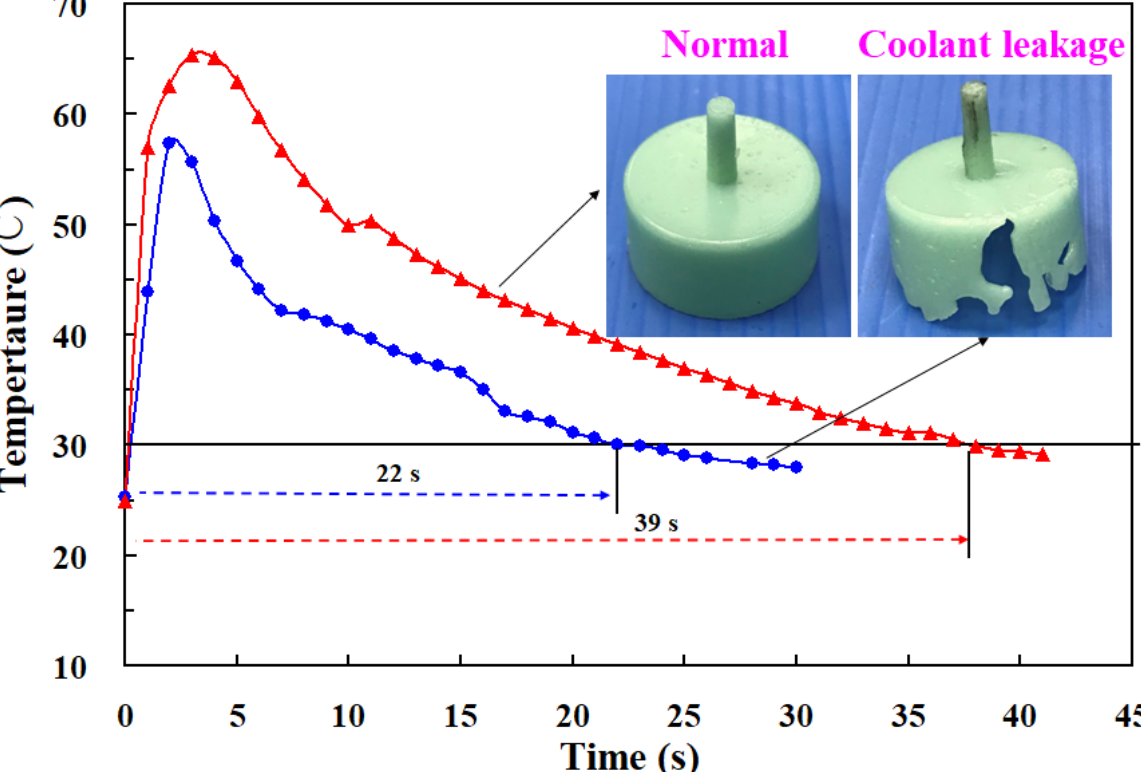
Figure 9. Cooling time of wax patterns for injection molds.